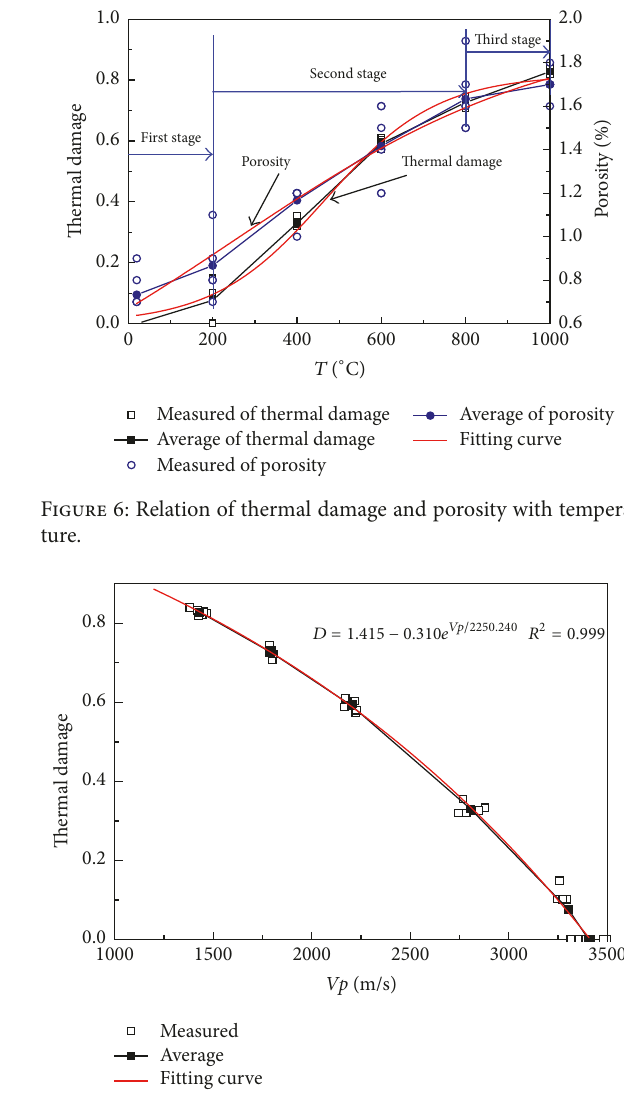
Figure 7: Relation of thermal damage and ultrasonic P-wave